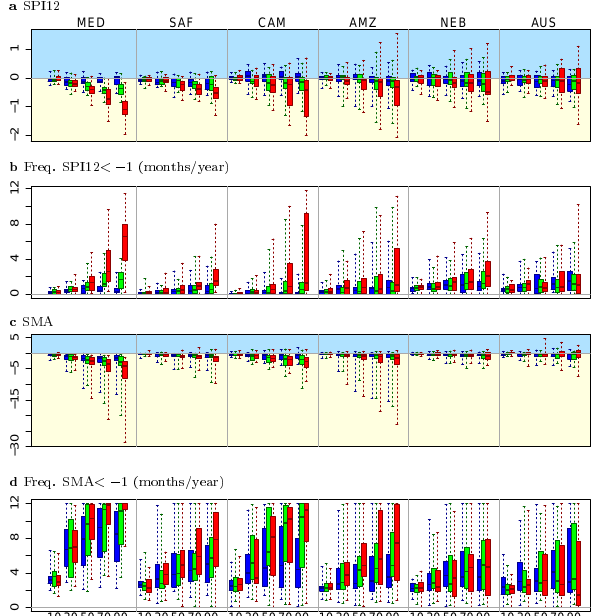
Fig. 8. Drying regions in the 21st century. (a) Box plots for 20yr average SPI12, regions where the median SPI12 decreases. The numbers at the bottom-most x-axis denote the central years in the 21st century of the 20yr windows. Colours indicate the respective GHG concentrations scenario, blue: RCP2.6, green: RCP4.5 and red: RCP8.5. (b) Months per year in which SPI12 < − 1. (c) and (d) Like (a) and (b) , but for Soil Moisture Anomalies (SMA). Changes are given as standard deviations with respect to 1979–2009 in (a) and (c) and as months per year in (b) and (d) .